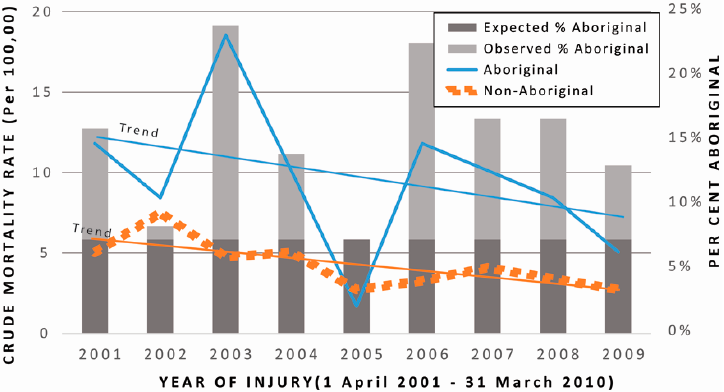
Figure 1. Temporal trends in the crude mortality rates for Aboriginal ( Blue line) and non-Aboriginal ( Orange line) children and youth ages 0–15, with respective trendlines, and proportion of total deaths among Aboriginal children, from 2001 to 2009.